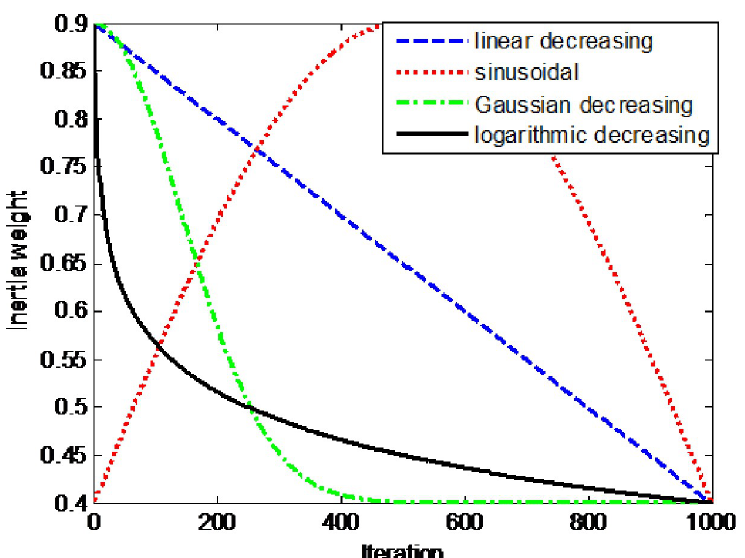
Fig 4. Inertia weight curves for different